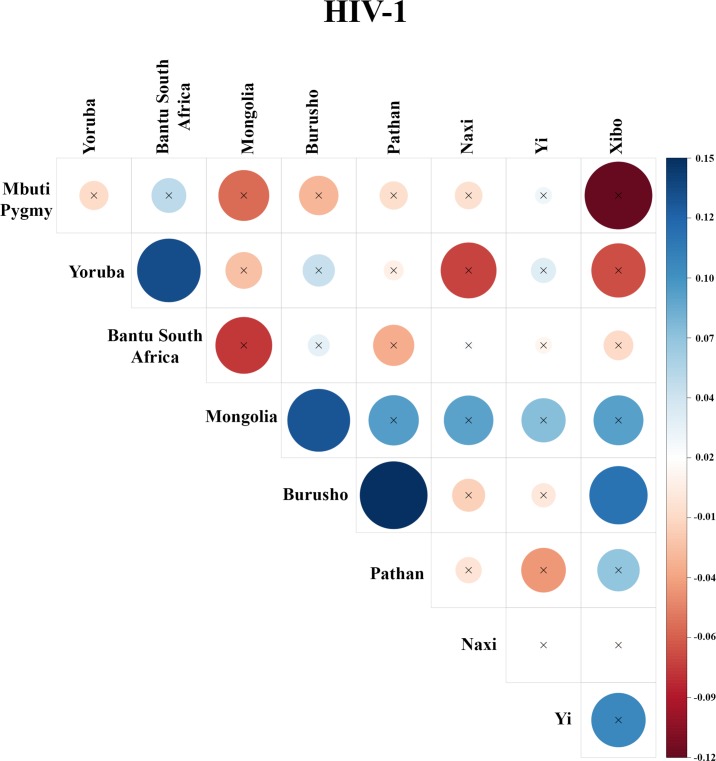
Overlap of selection targets associated with HIV-1.Each population was associated with a positive selection score for each gene interacting with Yersinia pestis. If gene scores were correlated for any population pair, there was significant overlap in the genes undergoing selection across both populations. We performed pairwise correlations among the 15 most selected populations to uncover the extent of overlap in selection targets. Kendall’s’ Tau-b coefficient ranged from -0.12 to 0.15. We identified 4 population pairs with significantly correlated positive selection scores.